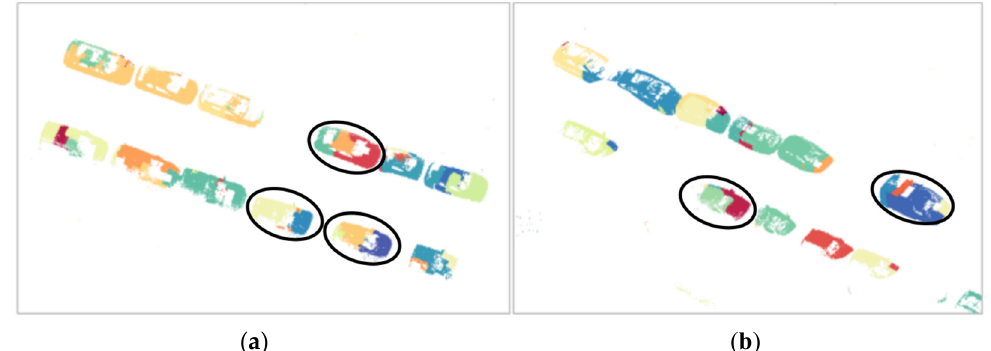
Figure 17. Partial neighborhood results of region growth based on relative tension. Note: Different neighborhoods are displayed in different colors. neighborhoods are displayed in different colors.